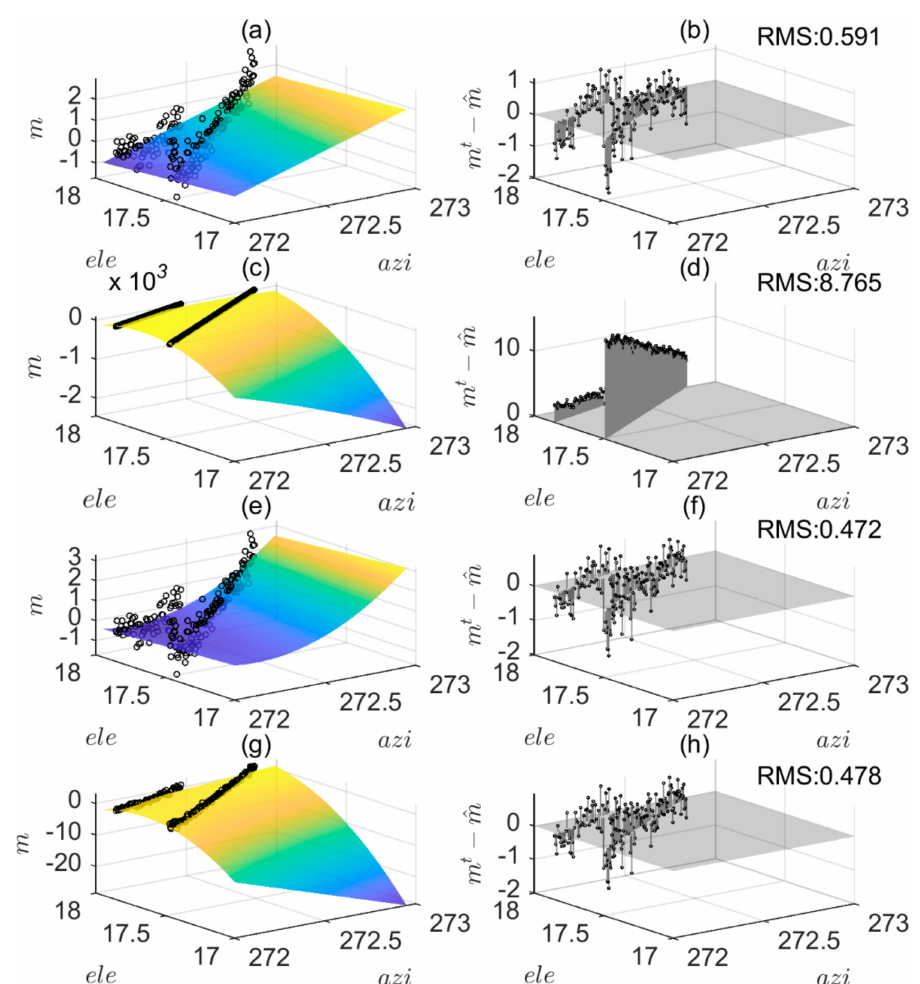
Figure 7. The fitting and application results of the four trend surface models constructed from the previous day of grid (18,273). ( a , b ) The fitting surface and residual plot after multipath correction of the linear trend surface model. ( c , d ) The fitting surface and residual plot after multipath correction of the T-MHM quadratic trend surface model. ( e , f ) The fitting surface and residual plot after multipath correction of the AT-MHM QA trend surface model. ( g , h ) The fitting surface and residual plot after multipath correction of the AT-MHM QE trend surface model. X, Y-axis unit: degree, Z-axis unit: